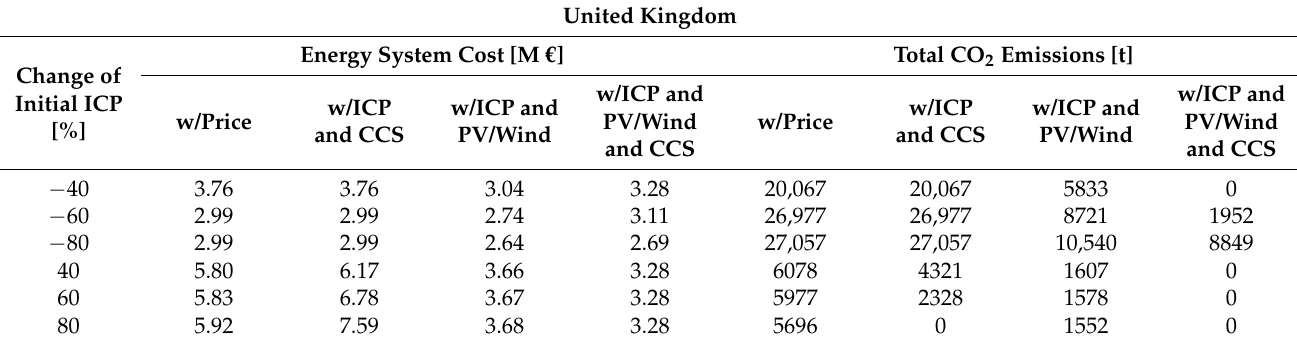
Table A3. Sensitivity analysis results for the British